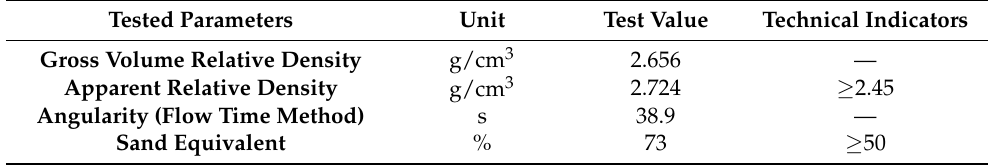
Table 3. Physical properties of limestone.